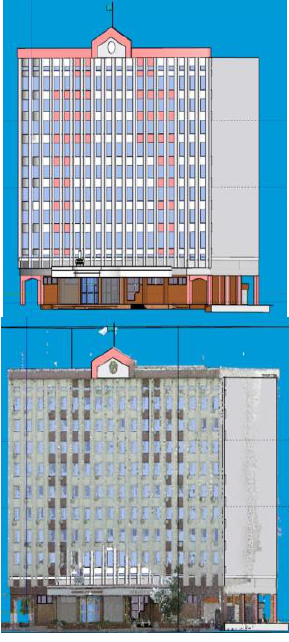
Figure 15 . The result of 3D modeling of the building of Satbayev